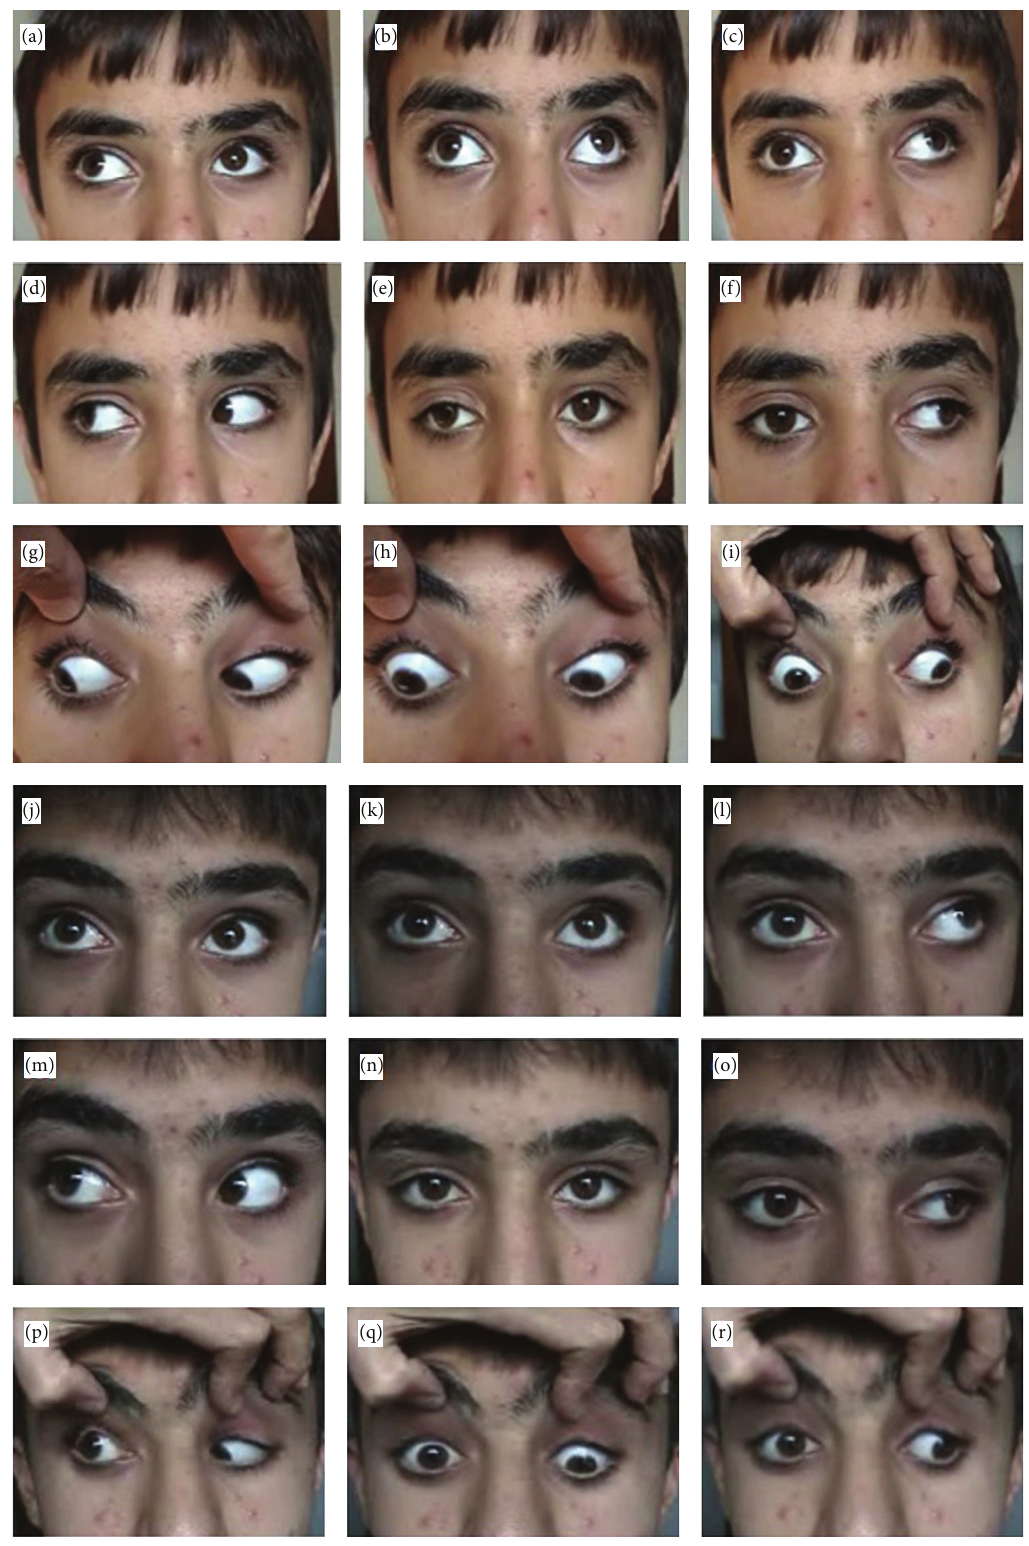
Figure 1: Preoperative (a–i) and postoperative (j–r) ocular alignment photographs of a right partial oculomotor nerve palsy in nine gaze positions (Tables 1 and 2, patient number 3). Limitation of adduction on left gaze (f), mild ptosis, and exotropia (e) is seen in preoperative pictures. Postoperative photographs showing both eyes are aligned in primary position (n), limited adduction function on left gaze (o), and right lateral gaze normal (m). A minimal limitation at inferior gaze occurred